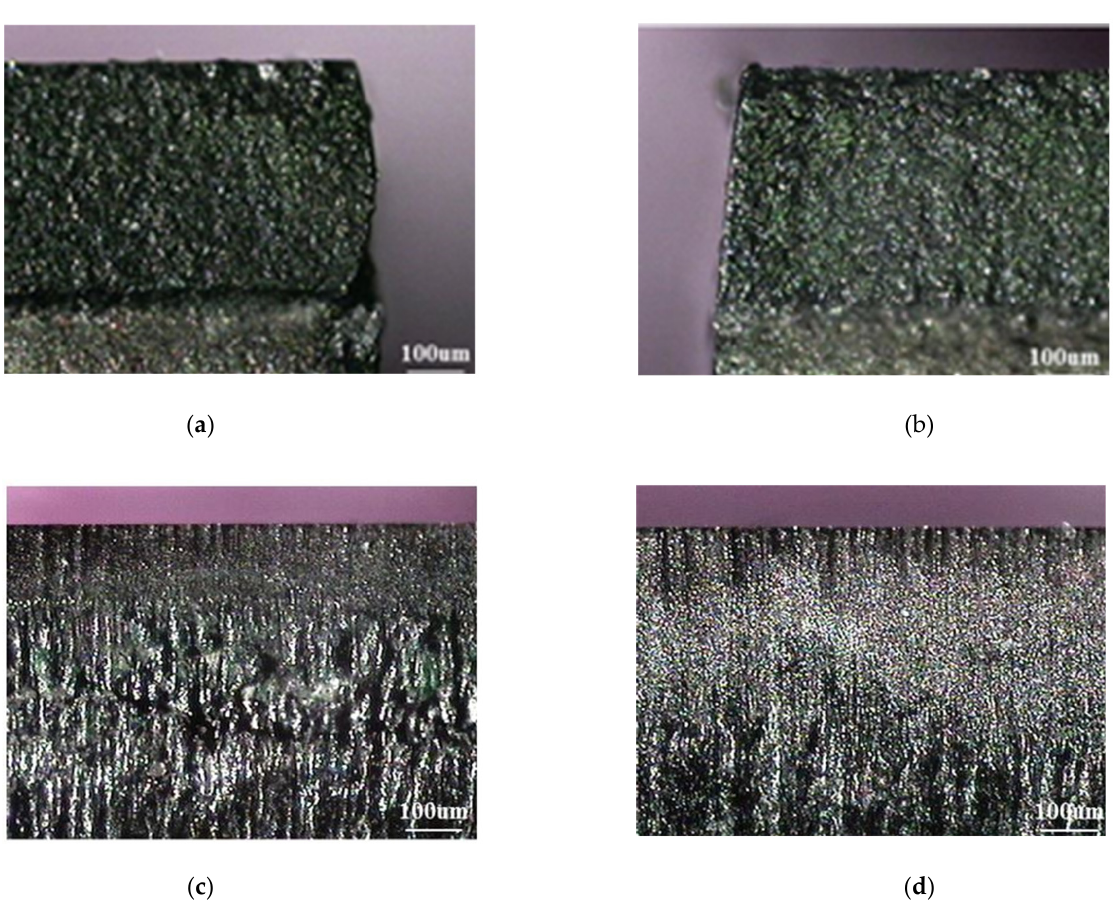
Figure 13. Optical microscope images of left and right sides of a laser cut PCD workpiece. ( a ) Left side, where the starting path begins; ( b ) right- side, where the final path ends; ( c ) surface of the cut side, where the starting path begins; ( d ) surface of the cut side, where the final path ends.